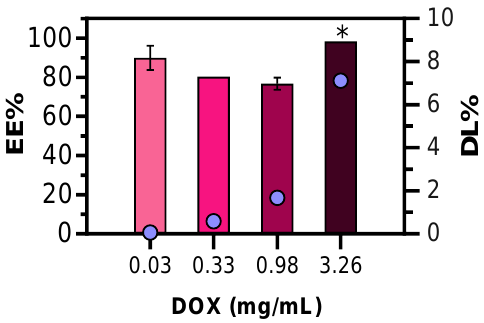
11 of 20 Figure 6. ( A ) STEM photograph of empty LNLCs M3 at 200 kV × 80.00 k. ( B ) Size distribution his- togram of empty LNLCs M3. The biophysical and thermodynamic properties of LNLCs are consistent with the crystallographic planes observed (Figure S3, Supplementary materials). The thermody- namic characterisation of DOX-LNLCs M3 by DLS and corroborated by DSC reveals a phase transition, which may correspond to the transition between the P-type cubic phase and the D-type cubic phase (Figure S3C,D).